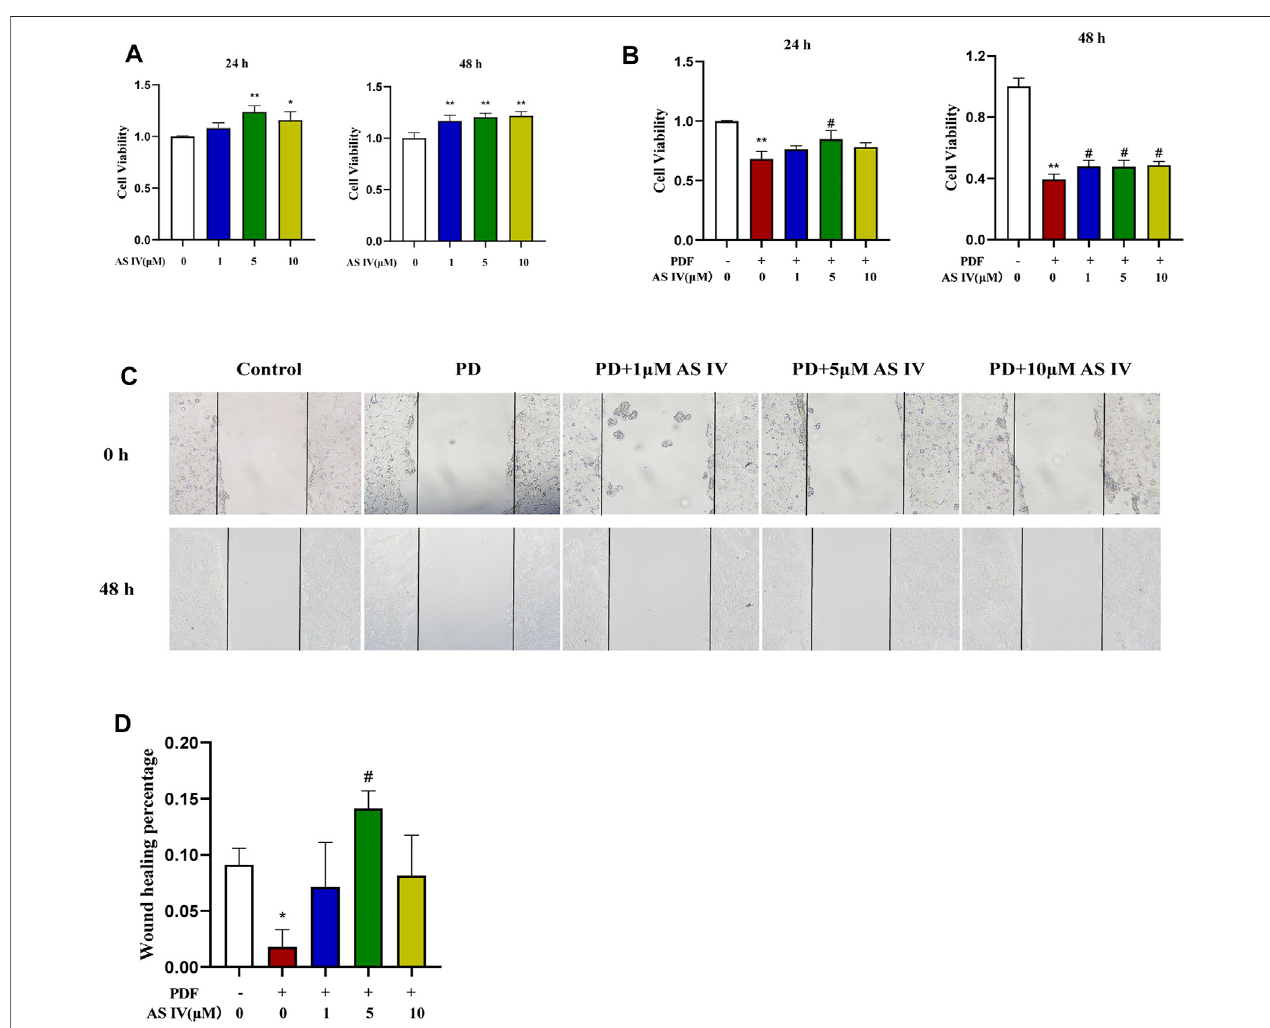
FIGURE 3 | Effects of AS IV on cell viability and scratch wound closure in PDF-treated T84 cells (A) T84 cells were treated with 1, 5, and 10 μ M AS IV for 24 h and 48 h. Cell proliferation was measured by CCK-8 (B) T84 cells were treated with PDF and 1, 5 and 10 μ M AS IV for 24 h and 48 h. Cell viability was measured by CCK-8 (C,D) Scratch assay of T84 cells incubated with 1, 5 and 10 μ M AS IV for 48 h. Data are presented as means ± SD of three independent experiments. * p < 0.05 or ** p < 0.01 versus the control group. # p < 0.05 or ## p < 0.01 versus the PD group.